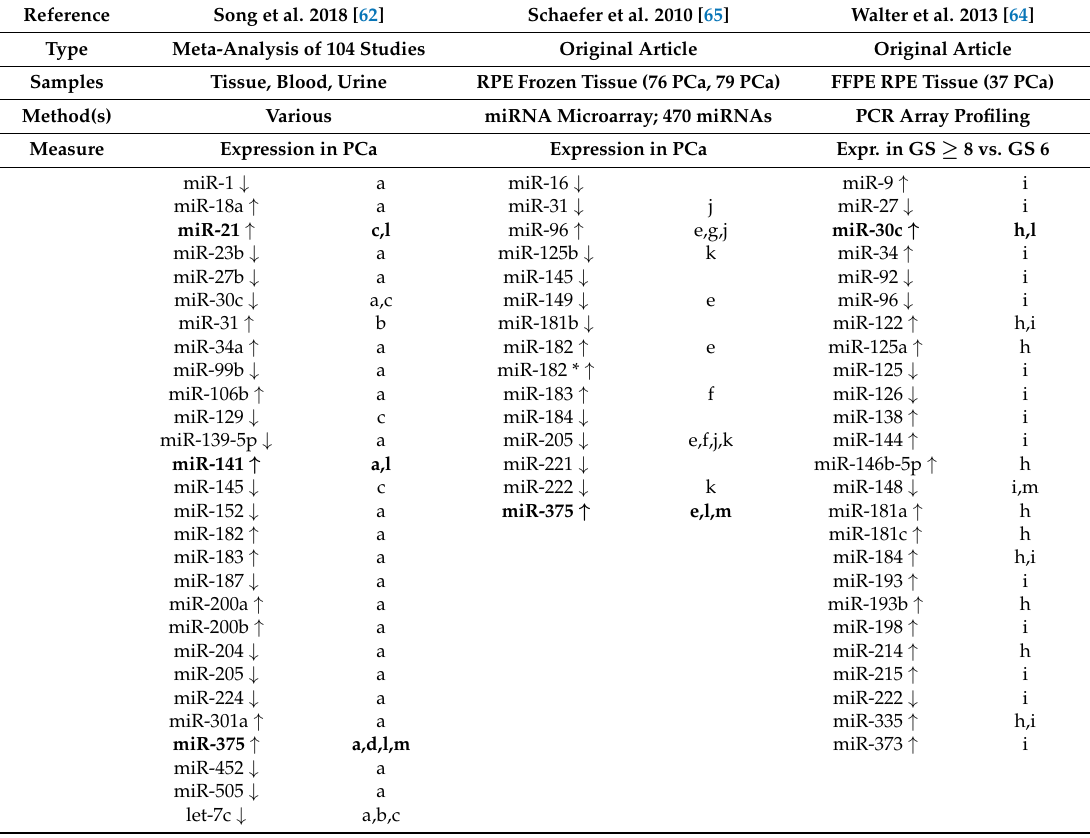
Table 2. Micro RNAs in prostate cancer